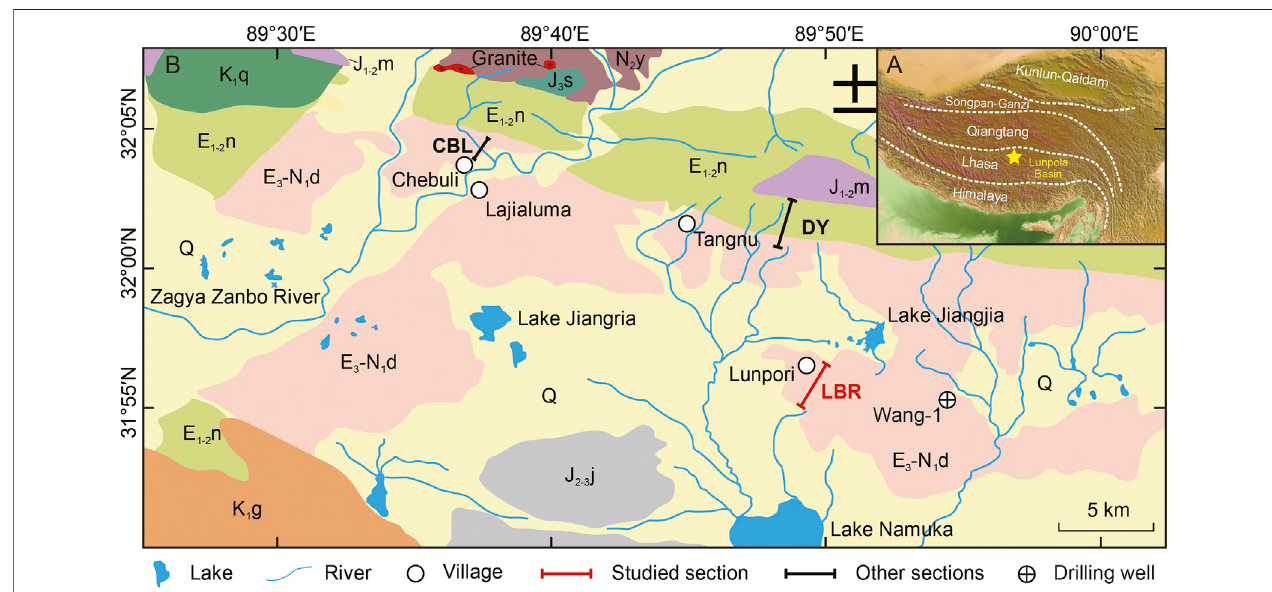
FIGURE 1 | Geological map of the studied region and section. (A) Digital elevation model shows the location of the Lunpola Basin within the Tibetan Plateau terranes. (B) LocationofthestudiedsectionattheLunporivillageintheLunpolaBasin.Alsoindicatedarepreviousstudiedsections,i.e.,Chebuli,Dayu,andWang-1(Sun et al., 2014; Ma et al., 2017; Fang et al.,